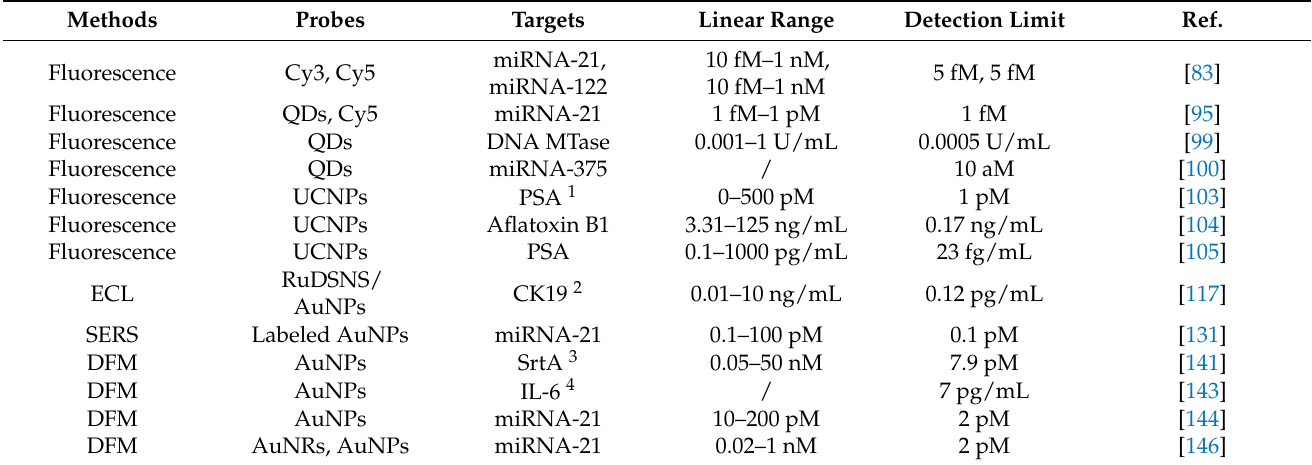
Table 1. Summary of the representative studies for